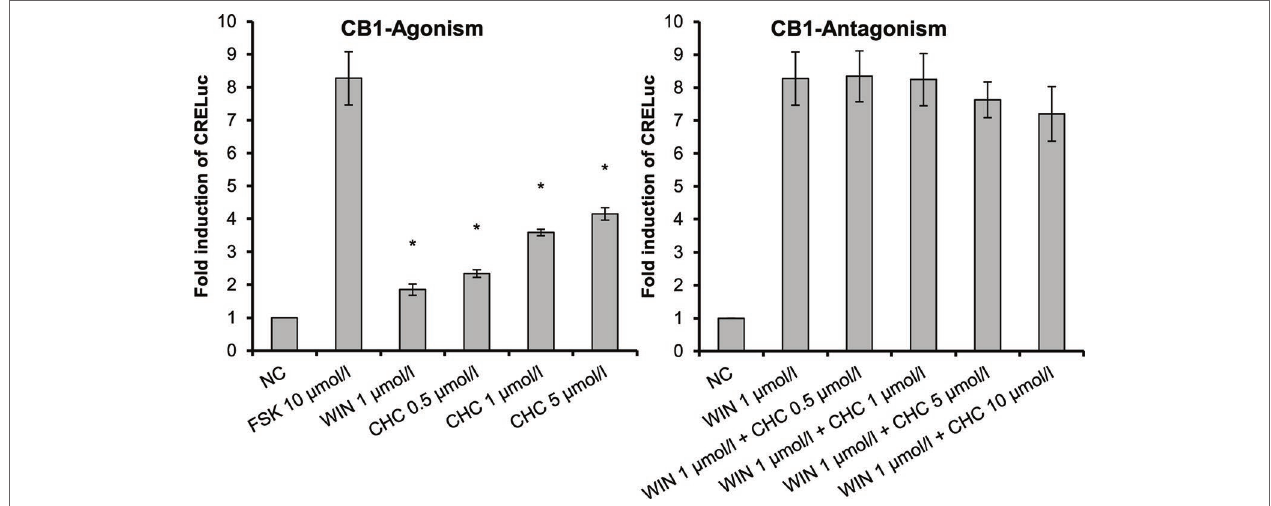
FigURE 2 | CB1‑receptor‑mediated agonistic effect of CHC ( 4 ) given as fold induction of CRE‑luc; CB, cannabinoid; CHC, cyclohexyl cannabidiolate, NC; negative control, FSK: forskolin; WIN, WIN 55212‑2; error bars represent SEM, * p < 0.1.